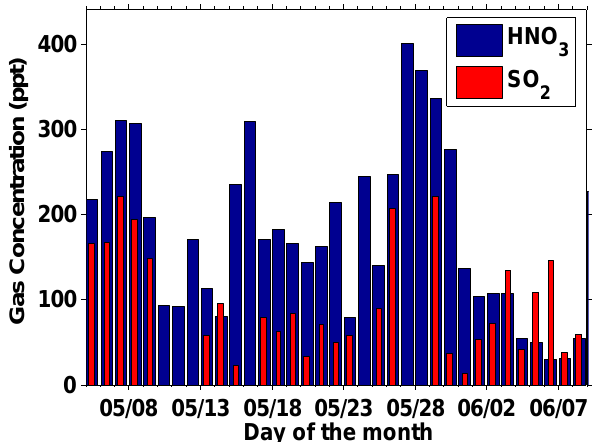
Fig. 14. Daily averages of acidic gaseous species (SO 2 , HNO 3